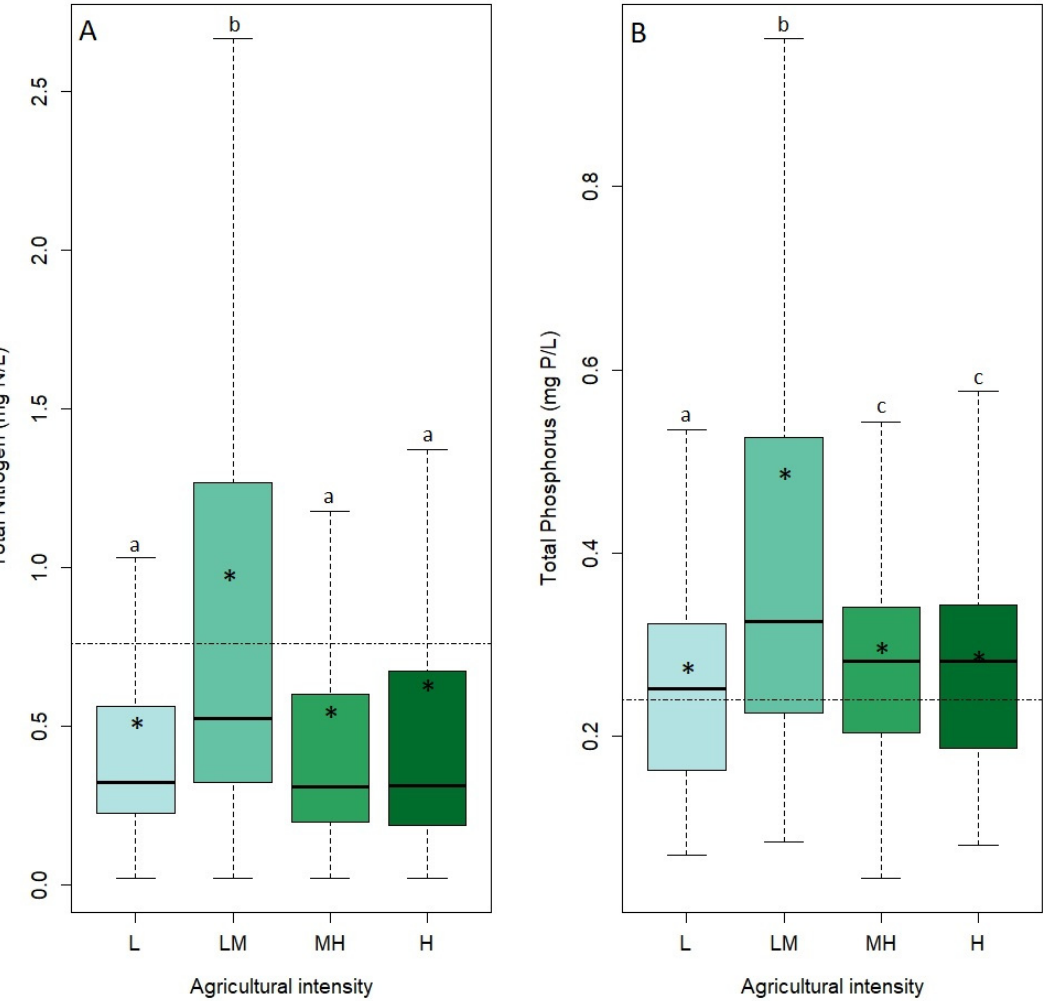
Figure 4. Box and whiskers plot with outliers excluded of total nitrogen (TN; ( A )) and total phos- phorus (TP; ( B )) values among agricultural intensities in the Cache River Watershed, Arkansas sam- pled weekly from October 2017 to September 2020. The black dashed lines represent the state 75th percentile standard of 0.760 mg N/L TN ( A ) and 0.240 mg P/L TP ( B ) and the asterisk represents mean TN and TP. Differences in lowercase letters indicate a significant difference ( α = 0.05) among intensities.